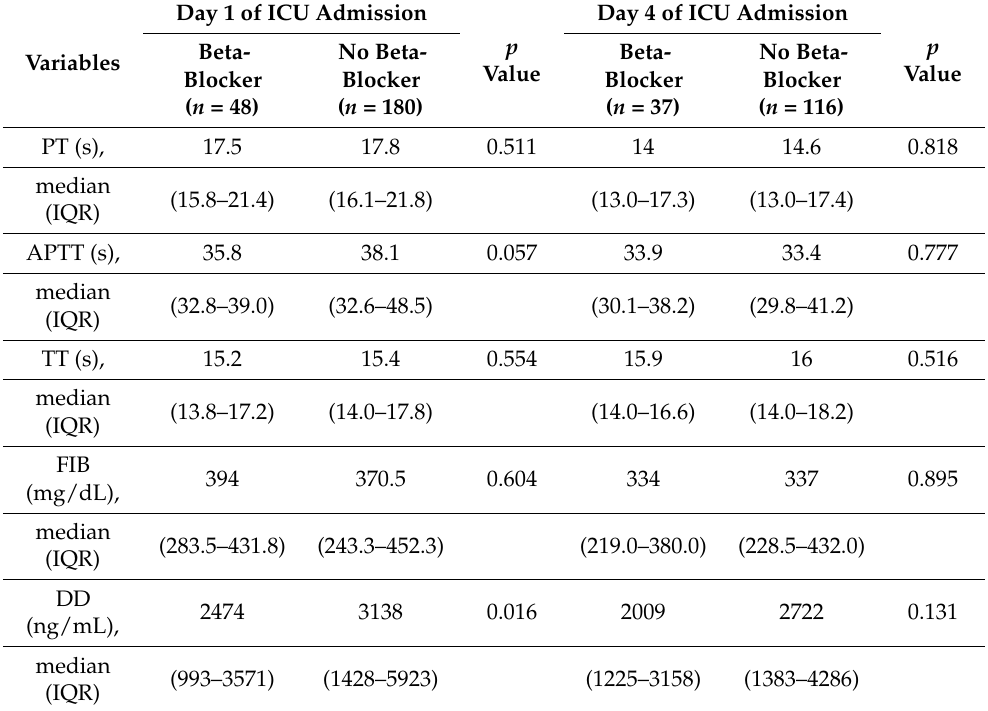
Table 3. Changes in markers of coagulation